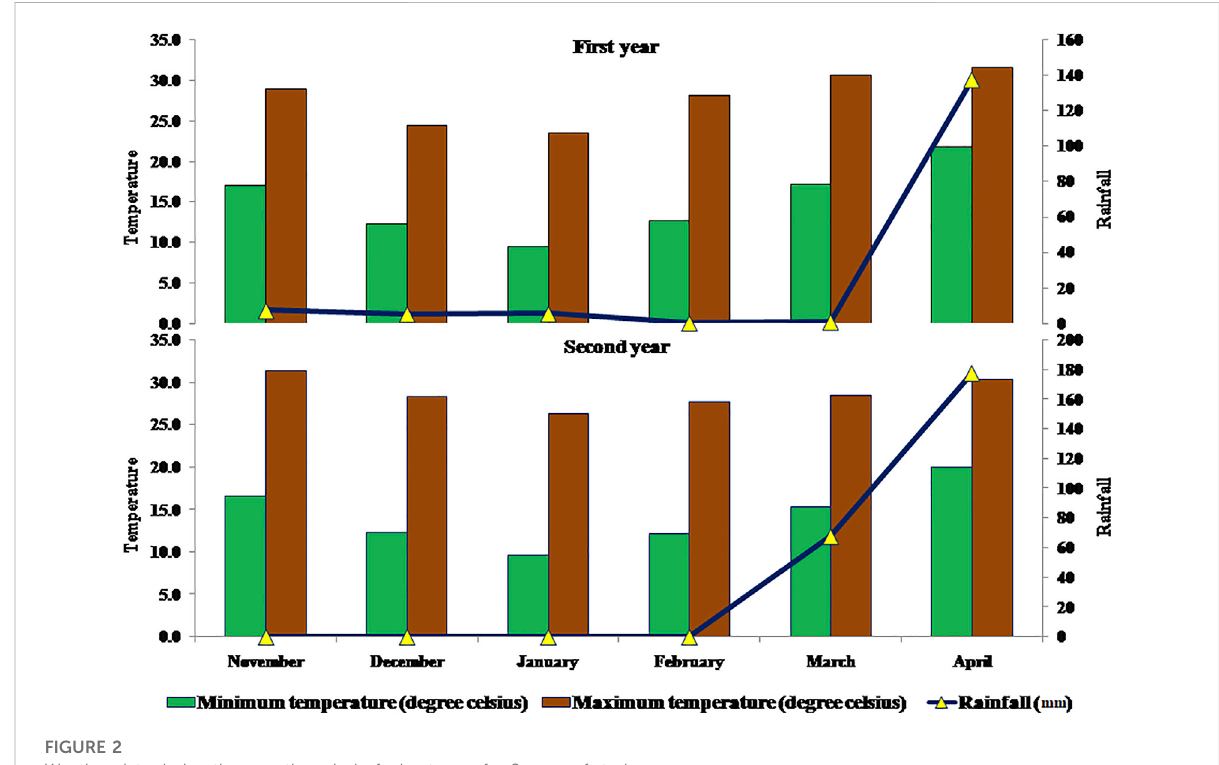
FIGURE 2 Weather data during the growth period of wheat crop for 2 years of study.